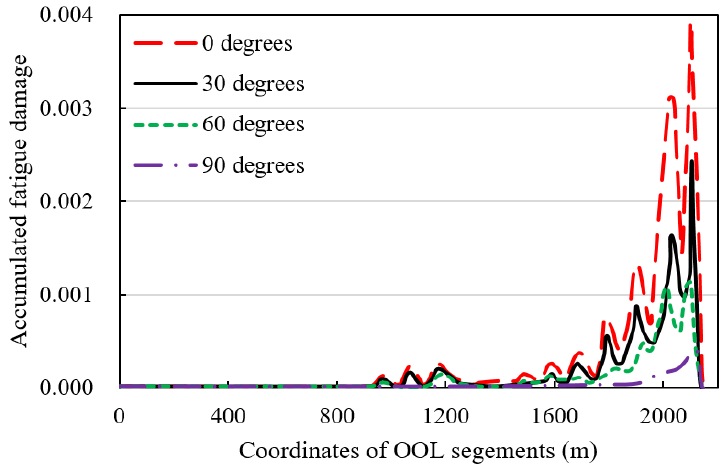
Figure 13. Fatigue damage of OOL under different wave